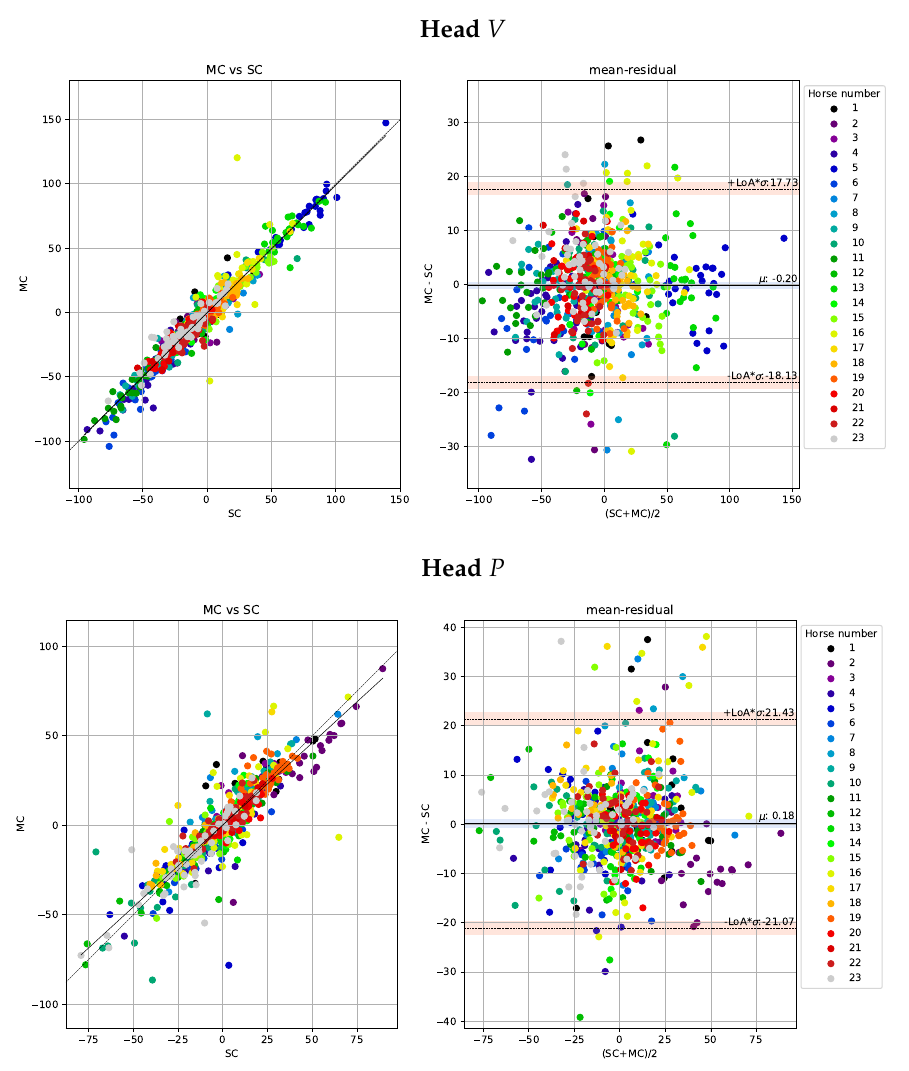
Figure 5. Scatter plots of the head metrics obtained per stride (n = 655) observed by the multi-camera marker-based motion capture system (MC) plotted against the observation by the single-camera markerless system (SC) are shown in the left sub-panels. Agreements between the systems, with limits of agreement (LoA) displayed as orange horizontal lines, are presented in the Bland-Altman plots in the right sub-panels. In the top row, we show the ∆ V (MinDiff) and in the bottom row, we show ∆ P (MaxDiff) defined in Section 2.7.1. For the purpose of visibility, we have fixed the range of the y-axis, causing a few samples with large residuals to be out of range. In the left plot, we have out of range residuals at 97.0 and − 55.2, and in the right plot out of range residuals are at − 48.9, − 81.5, 70.9, 56.0, − 47.1 − 71.5, − 44.4. While these samples have large errors they have little impact on the overall